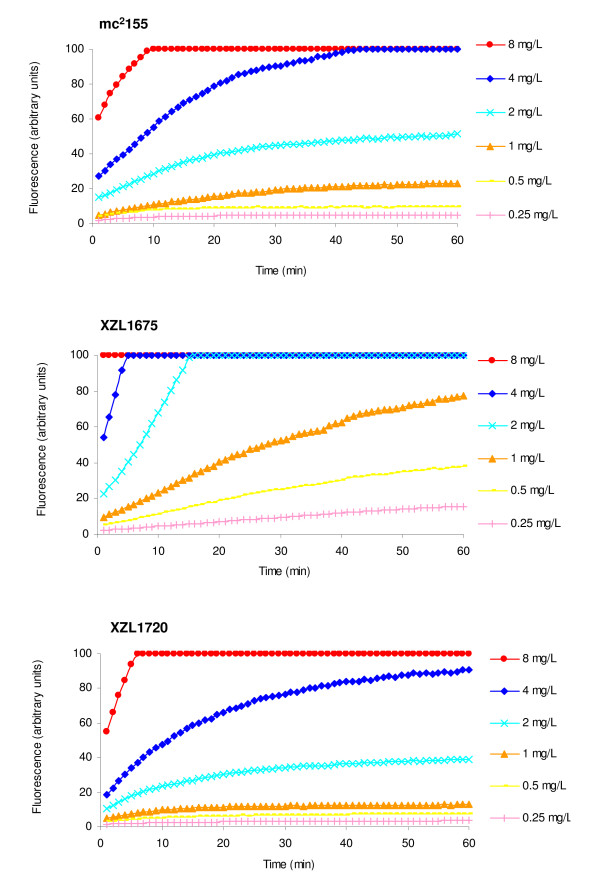
Accumulation of increasing concentrations of EtBr (0.25-8 mg/L) by M. smegmatis mc2155, XZL1675 (ΔlfrA) and XZL1720 (ΔlfrR).